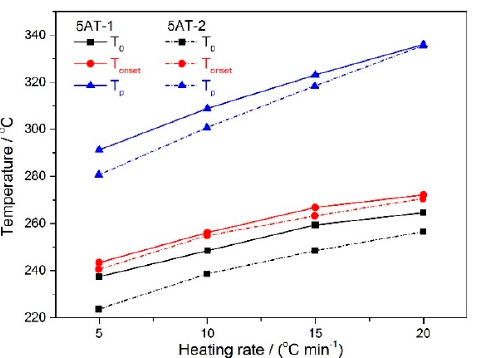
Figure 9. The e ff ect of varying the heating rate of 5AT–1 and 5AT–2 on T o , T onset , and T p